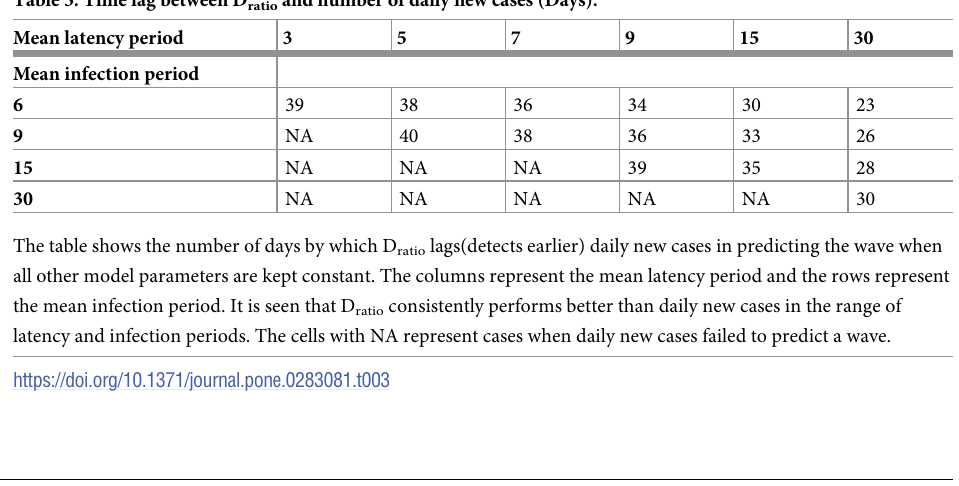
Table 3. Time lag between D ratio and number of daily new cases (Days).